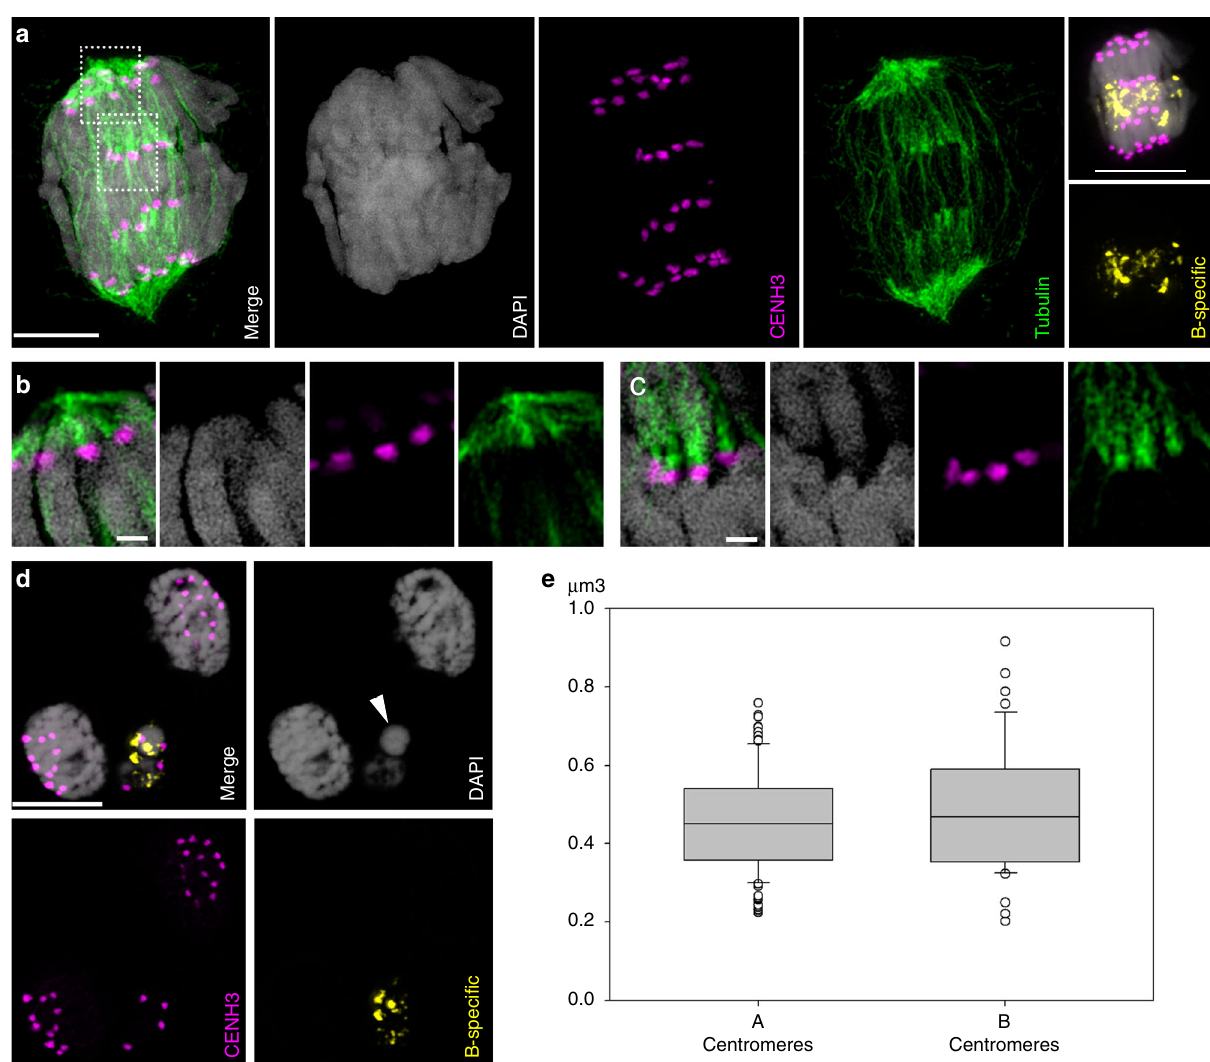
Fig. 2 Nondisjunction of centromere-active B chromosomes results in the formation of micronuclei. a Anaphase with lagging Bs after immunostaining of CENH3 (in purple) and α -tubulin (in green), for further details see Supplementary Movie 1. Scale bar, 5 µ m. FISH signals of the B-speci fi c probes AesTR-183 and AesTR-205 are shown in yellow. Scale bar, 10 µ m. The enlarged regions ( b , c ) are marked by rectangles. Interaction of α -tubulin with the CENH3- positive centromeres of ( b ) A- and ( c ) B chromosomes. Scale bar, 1 µ m. In total 7 anaphase cells with lagging B chromosomes were analyzed in 3 embryos using super resolution microscopy. On 5 from those cells interaction of α -tubulin with the CENH3-positive centromeres was consistently observed. d Formation of B-containing micronuclei during telophase. Note the position of centromeres on the opposite sides of the micronuclei resulting from the spindle microtubule tension during anaphase. The centromeric signals were observed for 60 micronuclei in 10 embryos. Scale bar, 10 µ m. e Box plot showing CENH3 signal volumes (Y-axis, µ m 3 ) on A- and B centromeres at anaphase. Measurements are performed for 7 anaphase cells and data are statistically treated. Because the data failed the normality test, a Mann – Whitney test for comparison of both centromere types was performed. The data were not signi fi cantly different ( P = 0.363). The box indicates the 25th – 75th percentiles, the line marks the median. The error bars indicate the 10th and 90th percentiles and the open circles the outlying points. Source data underlying e are provided as a Source data fi